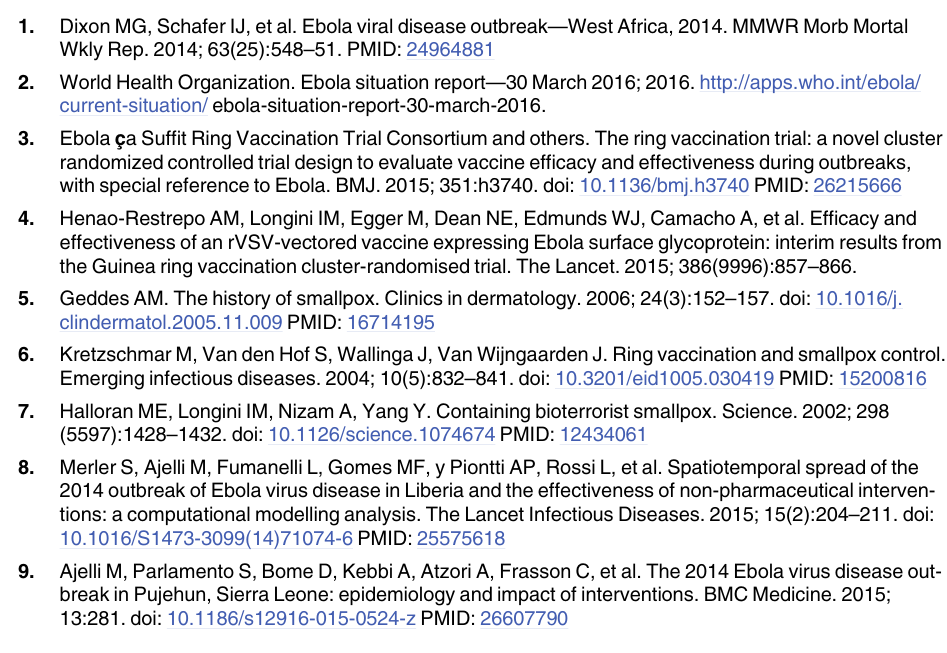
S3 File. Supporting video. Pujehun district, no contained outbreak. The movie shows the sim- ulated weekly number of cases of Ebola for the period of one year considering a reproductive number R = 1.6. On the left we show the evolution of an outbreak where we do not consider 0 any interventions while on the right we consider a ring vaccination intervention (C&CC, base- line parameters, see Fig 2 in the main text) that is not able to contain the outbreak ( > 300 cumulative cases). However, after one year the number of cases observedis significantly lower (345 and 194,599 with and without intervention respectively). Each dot represents a village in the Pujehun district and the colors indicate the number of cases in each one of them. The lower panel shows the weekly number of cases for the total of the region for both scenarios, without interventions and ring